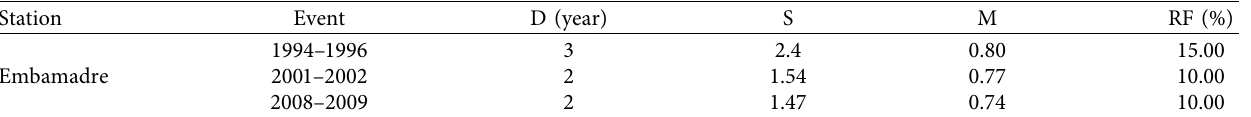
Table 6: Hydrological drought characterization in Ethiopian major river basins, Tekeze river basin.